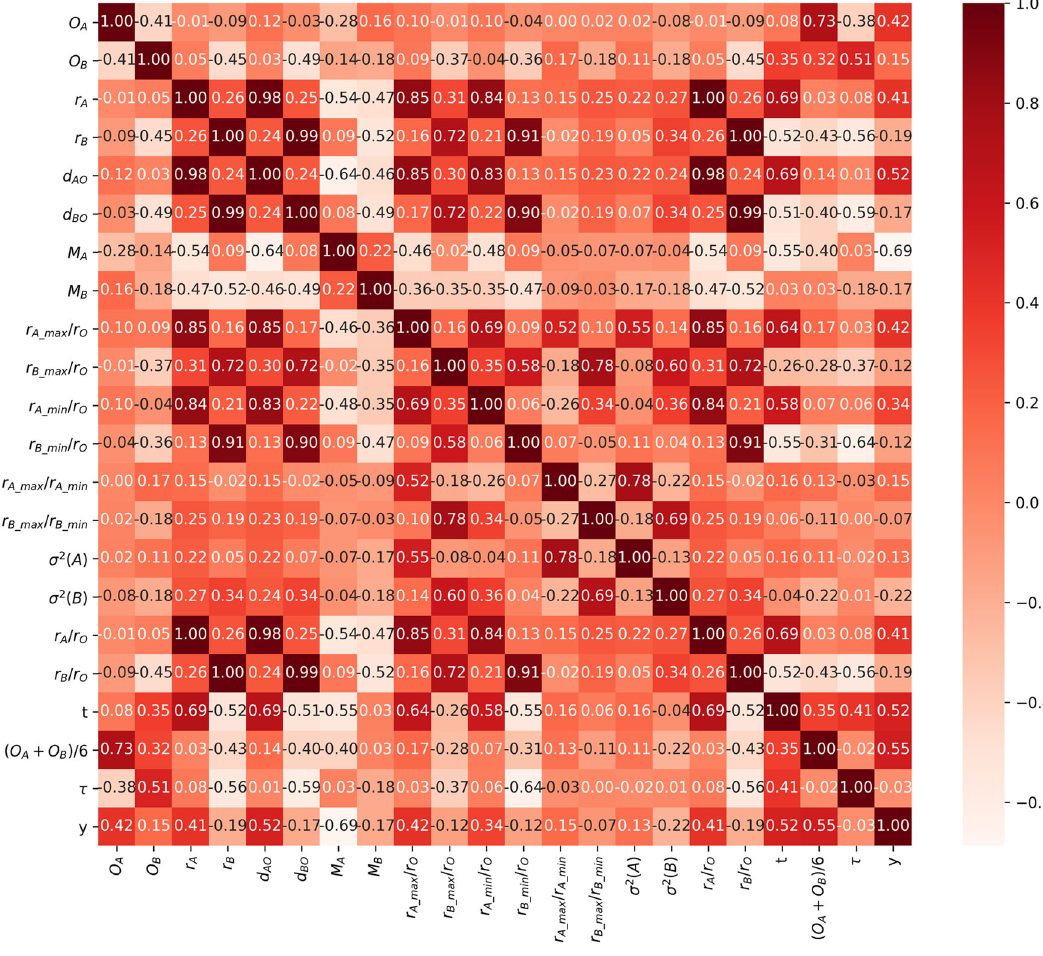
Fig. 3 Pearson correlation map for 21 features based on the dataset. The number represents the linear correlation between two